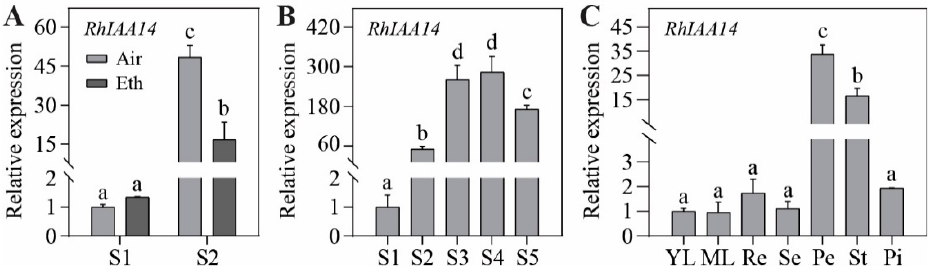
Figure 3. The qRT-PCR analysis of the expression level of RhIAA14 . ( A ) Expression of RhIAA14 in rose petals at stages 1 and 2 in response to ethylene. ( B ) Expression of RhIAA14 in rose petals during different stages of flower opening. Stages of rose flowering were defined as follows: S1, flower buds with loose sepals; S2, flower buds with open sepals; S3, flower buds with loose petals of the outermost layer; S4, flowers with loose petals of inner layers; S5, fully open flowers. ( C ) Expression of RhIAA14 in leaves and different floral tissues. YL, young leaf; ML, mature leaf; Re, receptacle; Se, sepal; Pe, petal; St, stamen; Pi, pistil. The qRT-PCR was performed using three biological replicates, and the data are presented as the mean ± SD. The letters indicate significant differences, in accordance with Duncan’s multiple range test ( p < 0.05). RhUBI2 was used as an internal control.